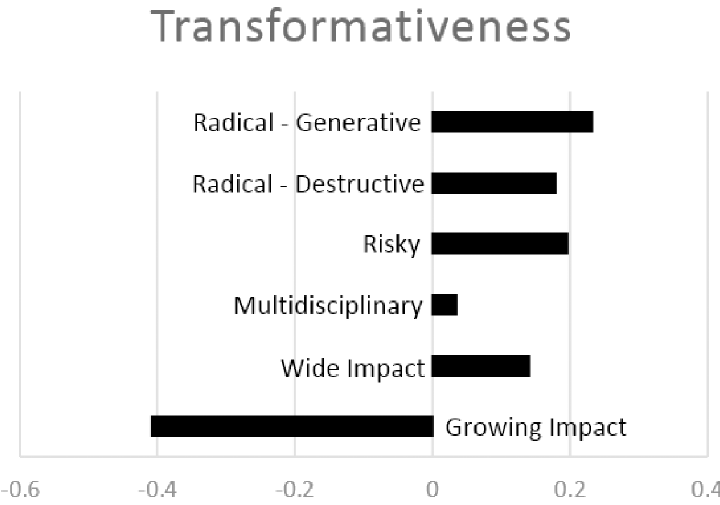
Fig 3. Results from a factor analysis of six aspects of HITS. The figure reports factor loadings on each aspect of transformative research from a factor analysis. The factor loadings indicate the extent to which the transformativeness metric loads on the (first) factor for each aspect of transformative research (excluding impact, which is treated